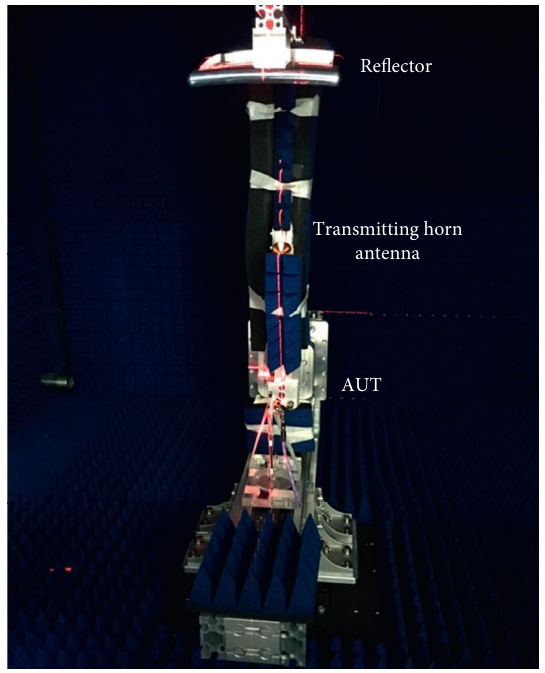
Figure 7: Far-feld measurement setup in a compact-range anechoic